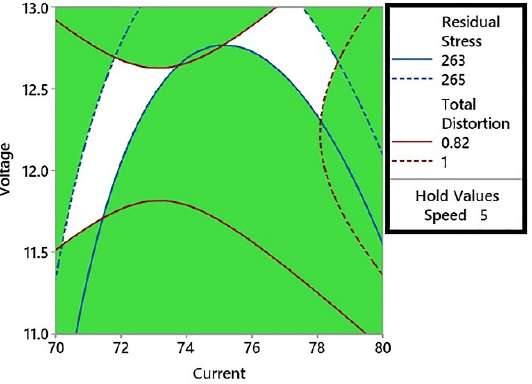
Figure 8. The overlaid contour plot of thee total distortion and residual stress with a speed of 5